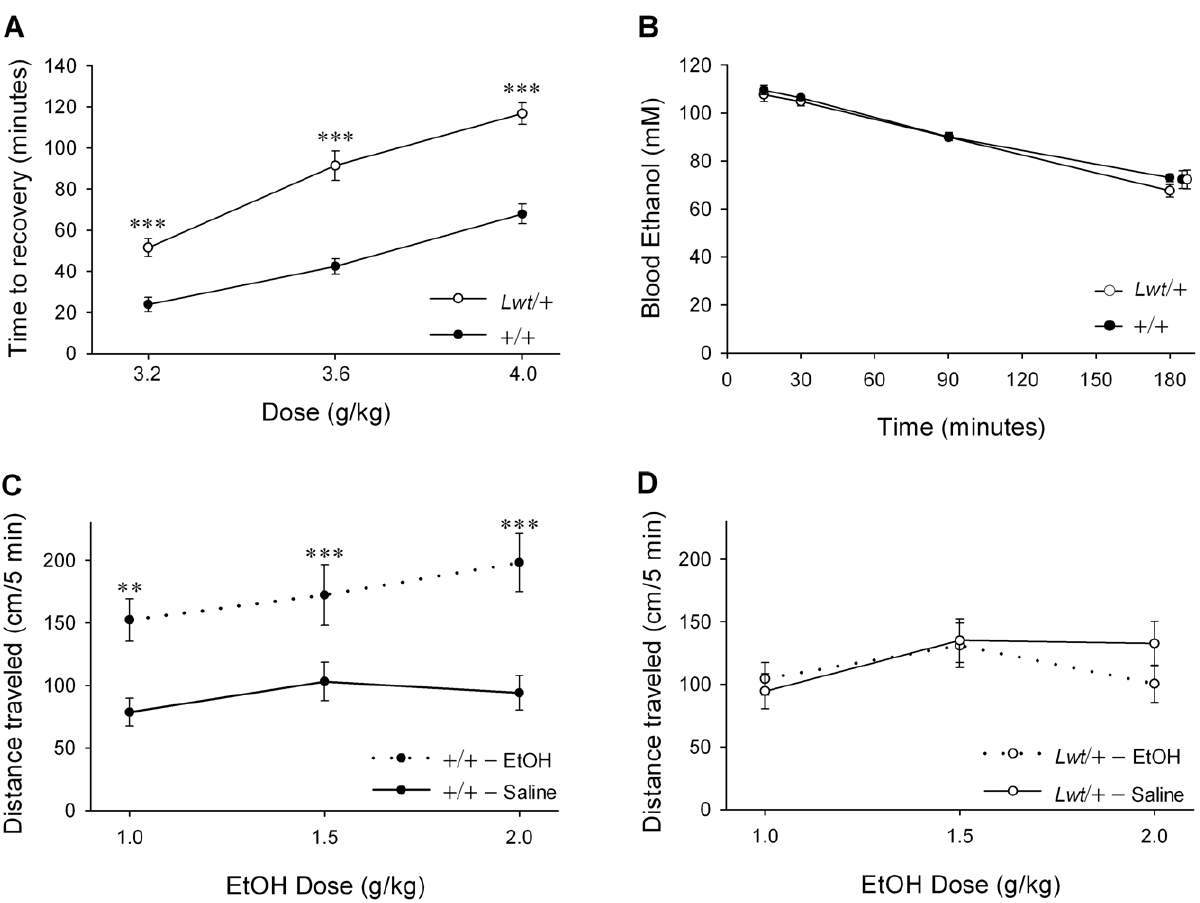
Figure 5. Alterationsin acute responses to ethanolin Lwt / + congenic mice. (A) Duration of loss of righting reflex in responseto theindicated dose of ethanol (g/kg, i.p.) was determined for both Lwt / + (n=13–18) and + / + male littermates (n=12–23). There was a highly significant increase in time to recovery at all doses tested in Lwt / + animals (*** P , 0.001, post hoc Tukey test). (B) Male Lwt / + (n=9) and + / + littermates (n=9) were tested for ethanol clearance after a 3.6 g/kg injection of ethanol (i.p.). These animals were sampled repeatedly at the times indicated. There were no significant differences between thegenotypes at any timepoint. In addition, three additional animals of each genotype were sampled only at the180 minute timepoint to control for repeated sampling. No significant differences were found between the 180 minute values from the repeatedly and acutely sampled groups. (C) Mean locomotor activity of + / + male mice (n=12–16) for the first five minutes after treatment with either saline (solid lines) or ethanol (dotted lines). (D) Mean locomotor activity of Lwt / + male mice (n=12–15) for the first five minutes after treatment with either saline (solid lines) or ethanol (dotted lines). Note that there is significantly higher locomotor activity ( P =0.038, post hoc Tukey test) in response to saline injection in Lwt / + mice relative to + / + mice in the locomotor activation experiment shown in (C) and (D). (** P , 0.01; *** P , 0.001, post hoc Tukey